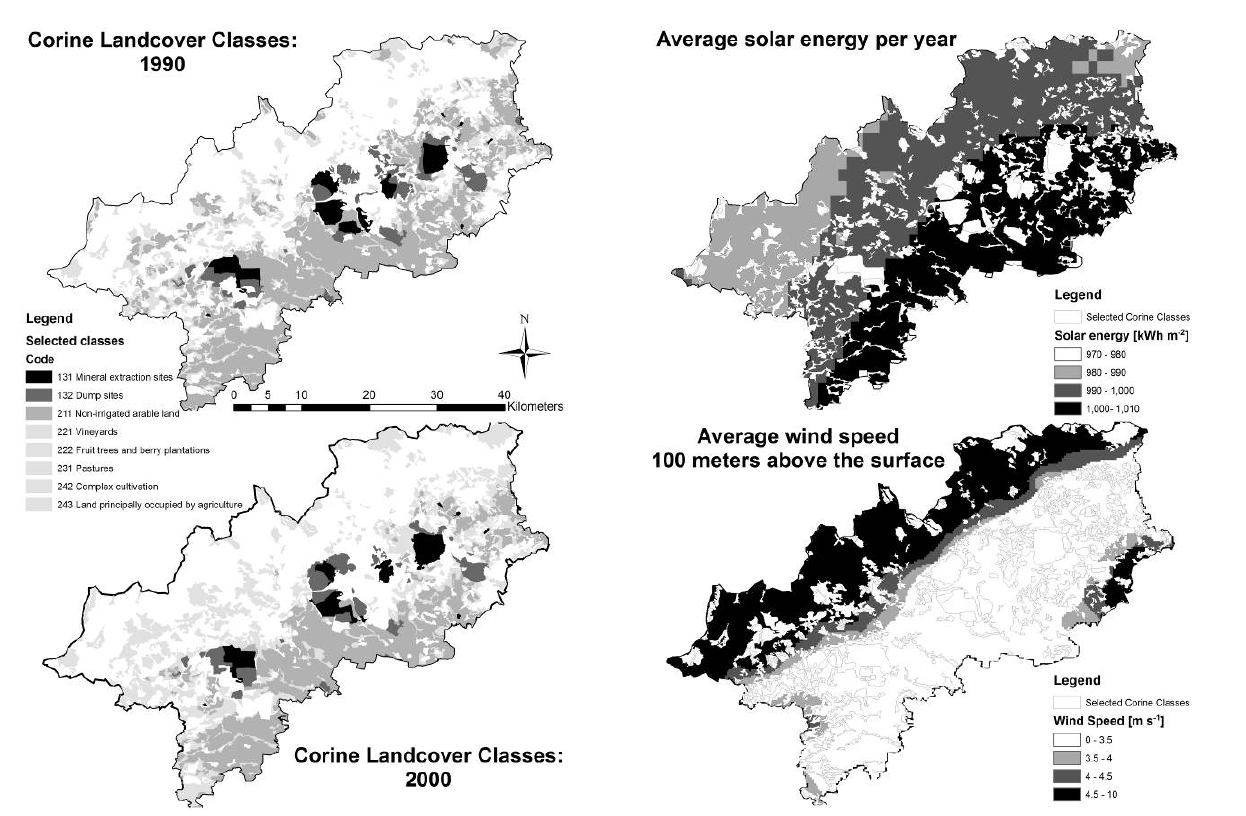
Figure 4. Selected classes from the land cover datasets in CORINE for land cover mapping in 1990 and 2000.